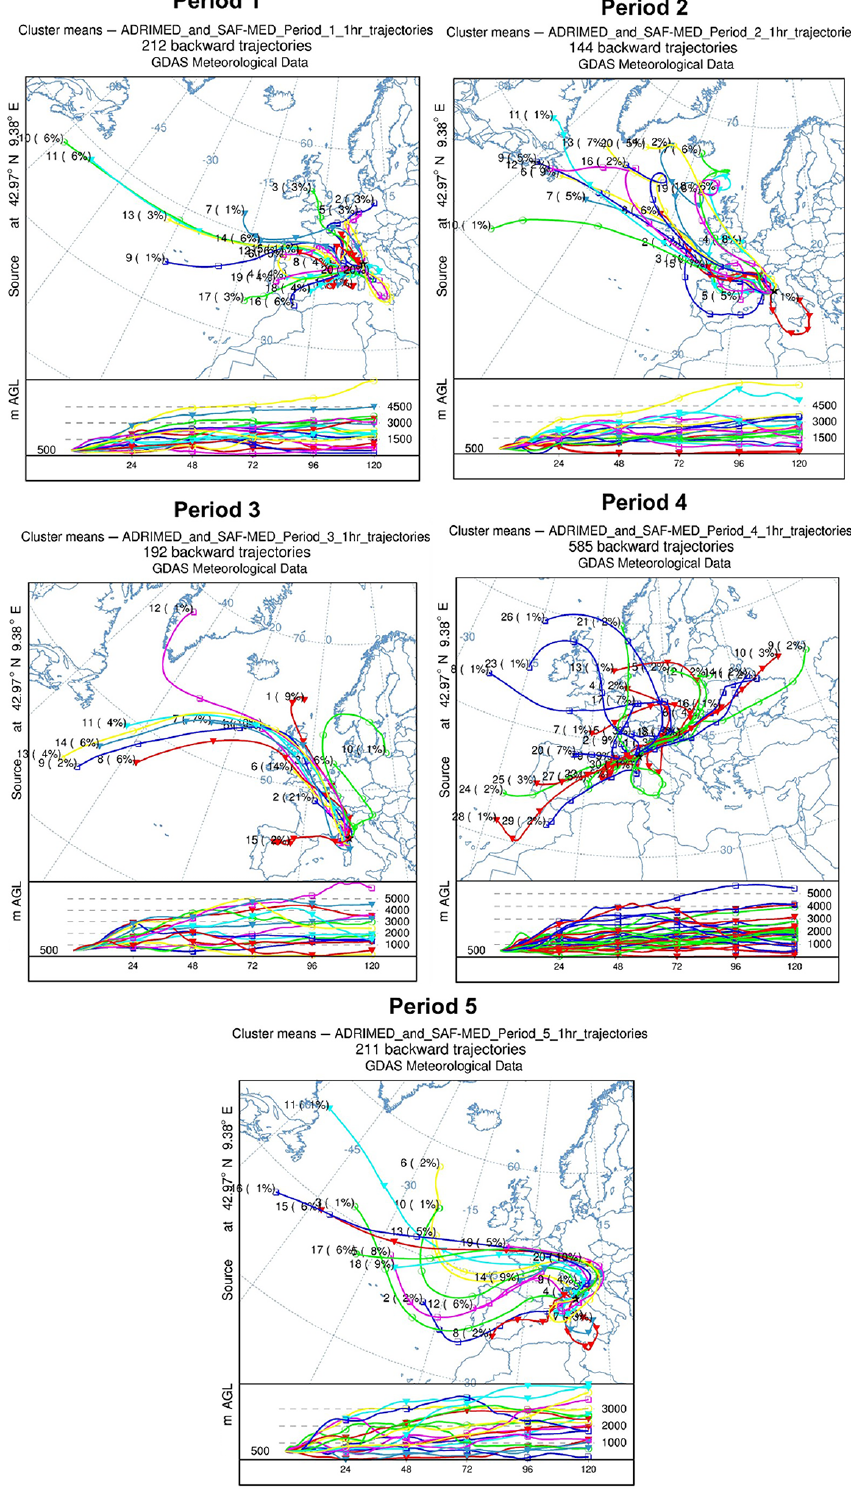
Figure 1. Cluster analysis of 120h back-trajectories calculated using the HYSPLIT model, ending at Cap Corse sampling site at 500m above ground level every 1h for the five periods identified during ADRIMED and